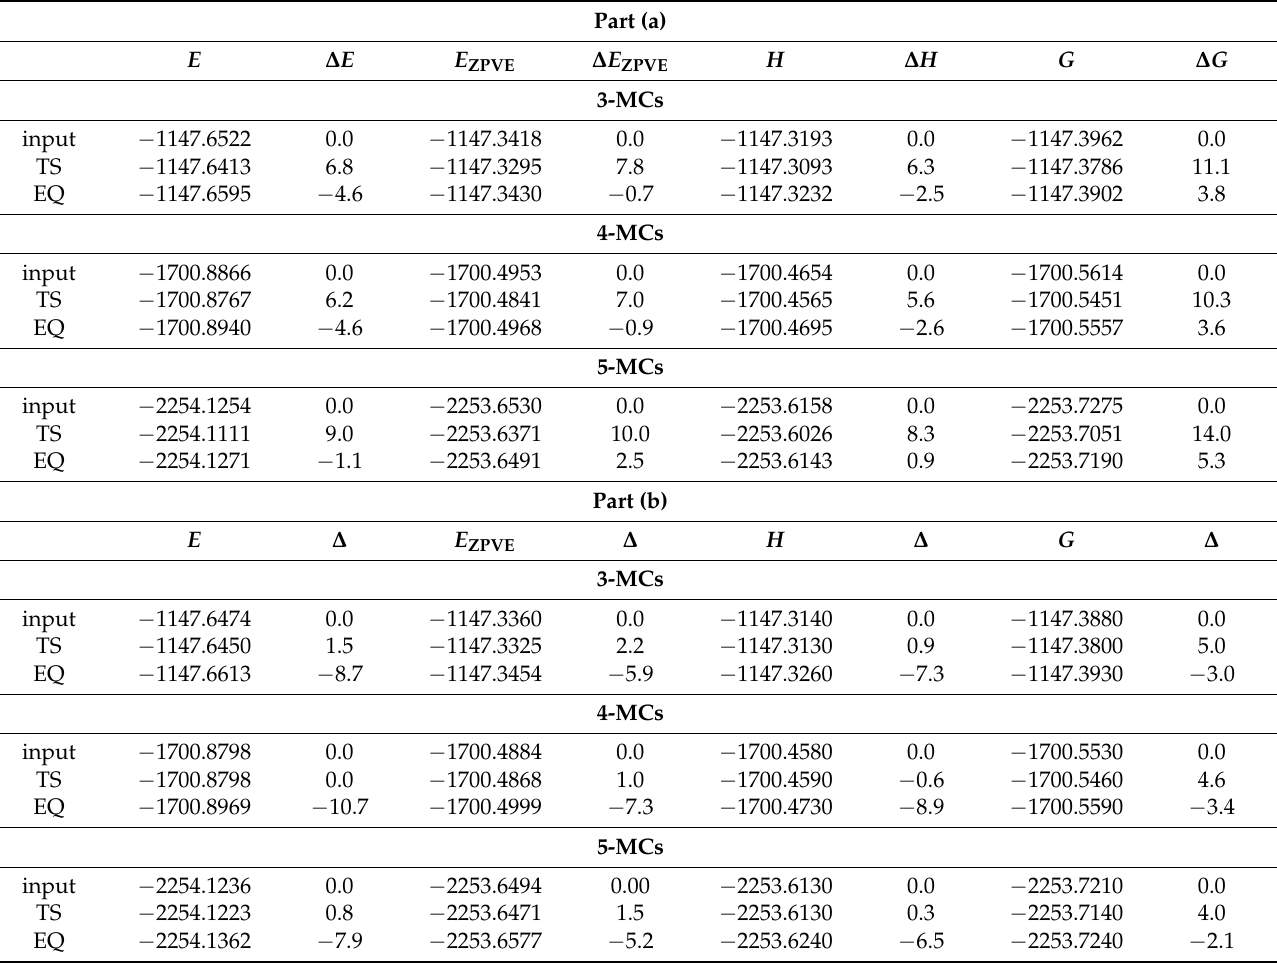
Table 2. Energies (in au at the RB3LYP/6-31+G(d,p)/GD3 level in DMSO) computed for the first stage of the catalytic process [23], i.e., the concurrent H-transfer from 1 to 2 and CN-bond formation between 1 and 2 . The lowest energy pre-organized 3-MC, 4-MC, and 5-MC with 1a (part ( a )) and 1b (part ( b )) were used as input structures for computational modelling. Relative to the energy of the relevant input molecular complex, energy changes ( ∆ ) for a transition state (TS) and equilibrium product (EQ) of the first stage are reported in kcal/mol. Part